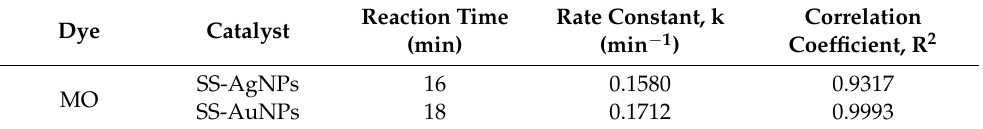
Table 3. Values of methyl orange